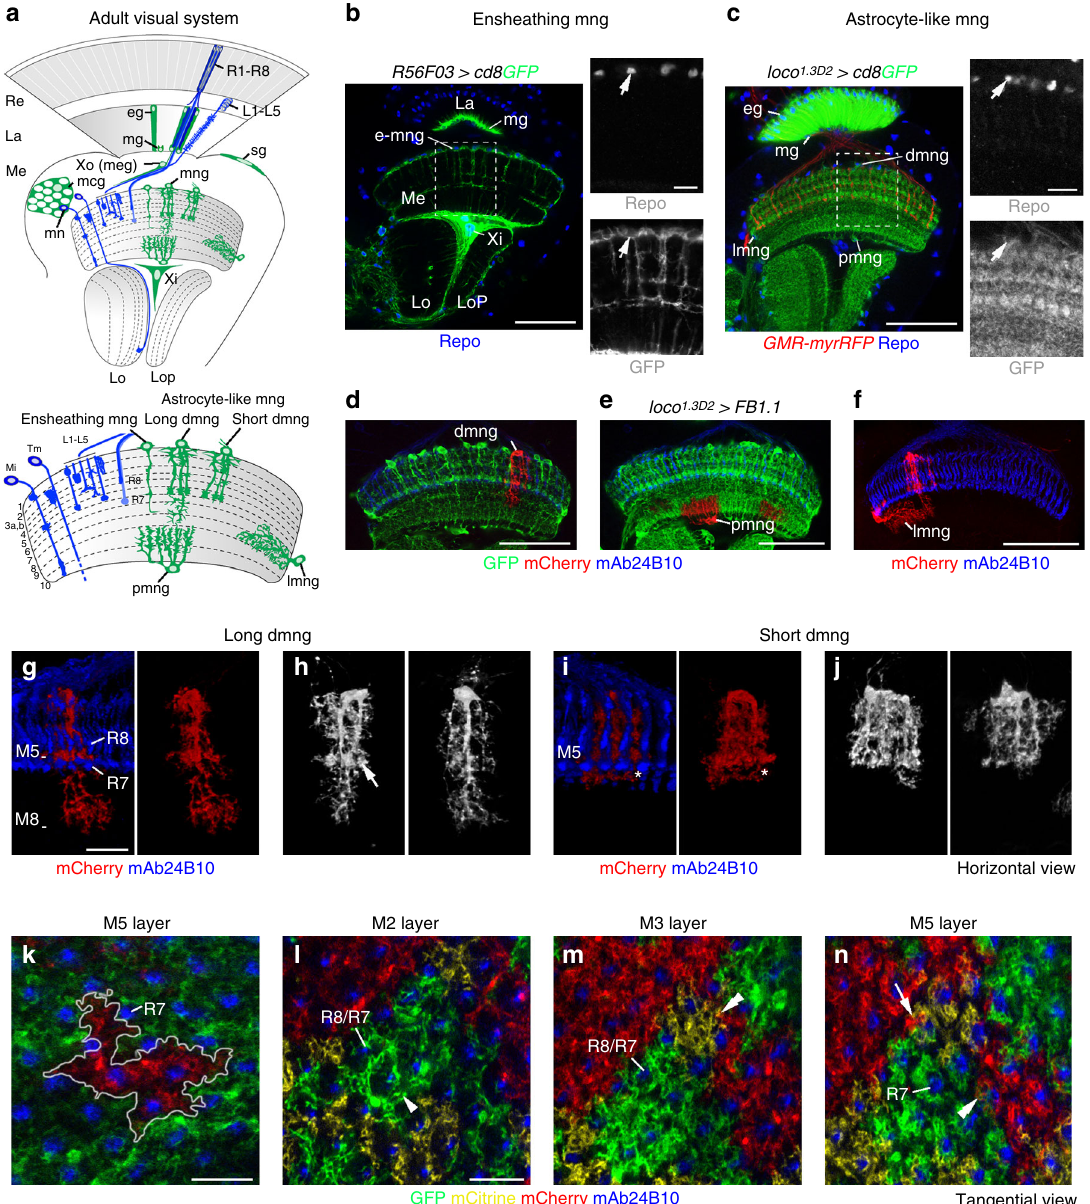
Fig. 1 Four astrocyte-like glial variants in the medulla. a Schematic of glial subtypes in the adult Drosophila optic lobe. dmng distal medulla neuropil glia, eg epithelial glia, L1-L5 lamina neurons, La lamina, lmng lateral mng, Lo lobula, Lop lobula plate, mcg medulla cortex glia, Me medulla, mg marginal glia, Mi medulla intrinsic neurons, mn medulla neurons, pmng proximal mng, R1-R8, R8/R7 R-cell and axon subtypes, Re retina, sg surface glia, Tm transmedullary neurons, Xi inner chiasm glia, Xo or meg outer chiasm glia or medulla glia. R56F03-Gal4 ( b ) and loco 1.3D2 -Gal4 ( c ) drive expression of UAS-cd8GFP ( green ) in ensheathing mng (e-mng) and astrocyte-like mng, respectively. R-cell axons were labeled with GMR-myrRFP ( c , red ), and glial nuclei with Repo ( b , c , blue , arrows ). d – n Single astrocyte-like mng were visualized using loco 1.3D2 -Gal4 and UAS-FB1.1 . Processes of dmng in fi ltrate medulla neuropil layers M1-M8 ( d